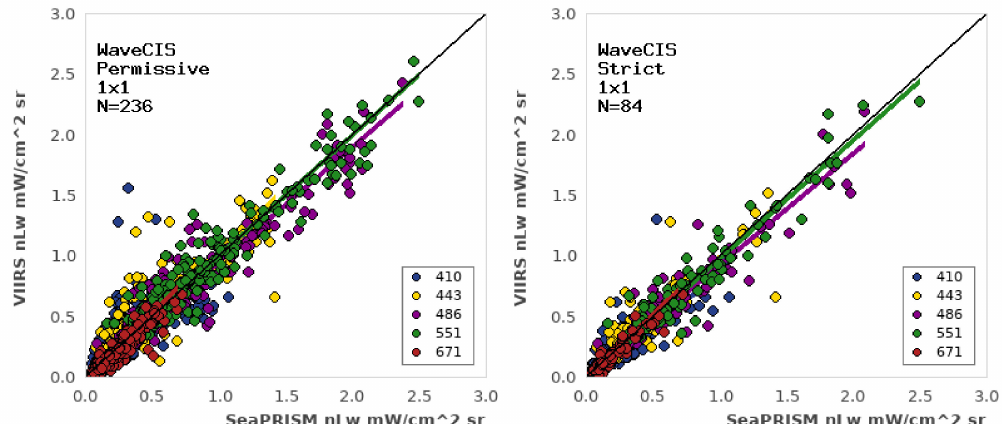
Figure 4. WaveCIS–VIIRS comparison, June 2014–May 2019, center (in situ) pixel only. Left: permissive protocol; right: strict protocol. The number of match-ups decreased by almost 65%.